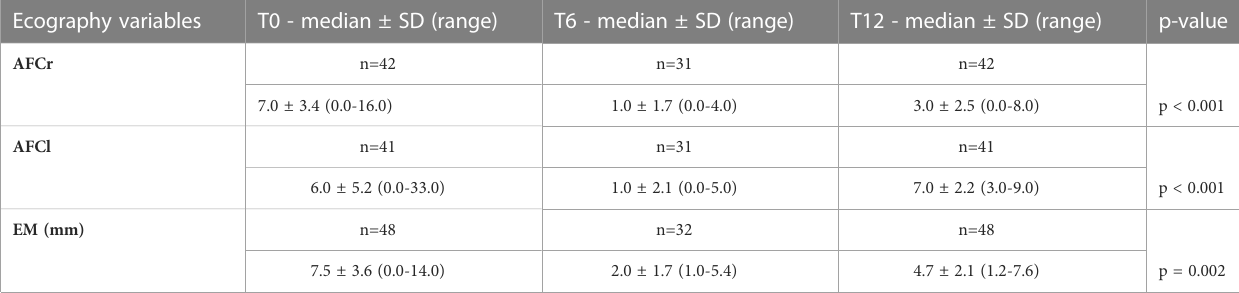
AFCr, antral follicular count right; AFCl, antral follicular count left; EM Endometrial